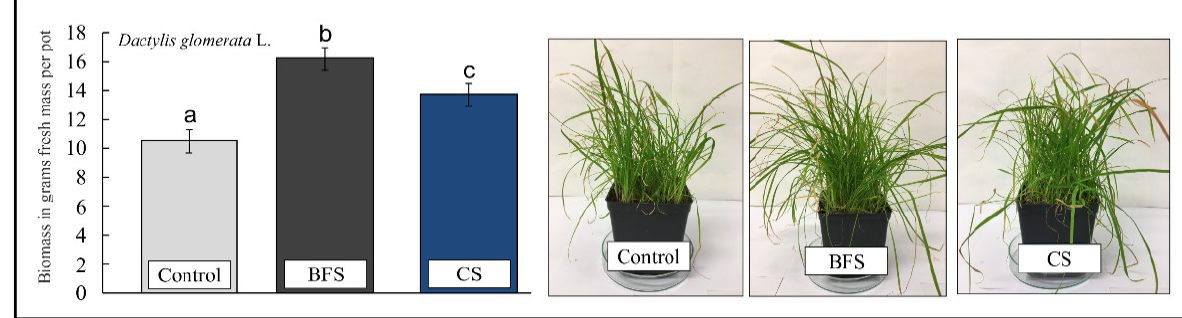
Figure 2. Above-ground biomass yield of Dactylis glomerata L. under different treatment conditions (Control, BFS, and CS).